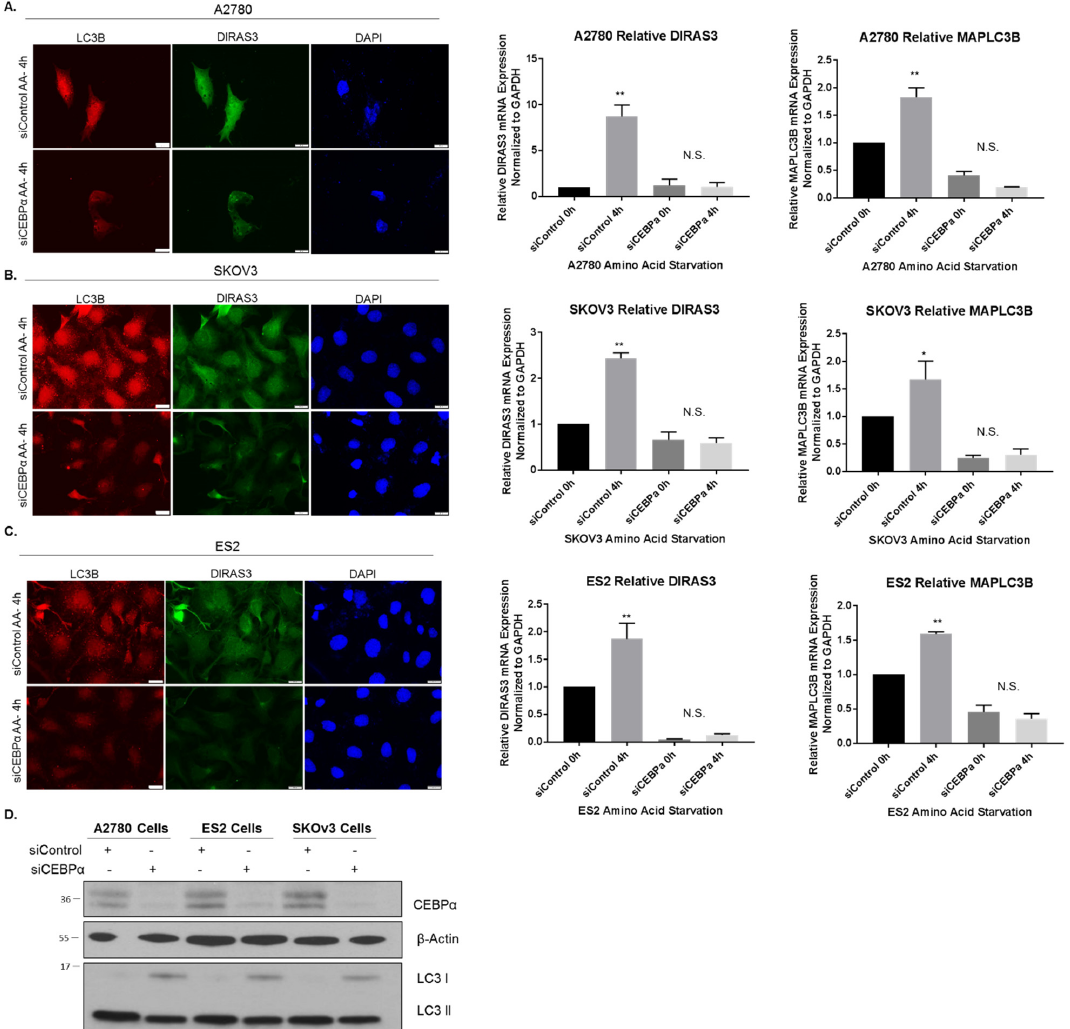
Figure 7. Knockdown of CEBP α reduces DIRAS3 upregulation following amino acid deprivation. A2780 ( A ) SKOv3 ( B ) and ES2 ( C ) ovarian cancer cells were treated with control siRNA or siRNA against CEBP α for 72 h prior to amino acid starvation for 4 h. Immunofluorescent staining was performed as indicated. qRT-PCR was performed and DIRAS3 and MAPLC3B mRNA expression was determined relative to GAPDH. The experiment was performed three independent times with technical duplicates. Bars indicated the mean ± the standard deviation; * p < 0.05 and ** p < 0.01. ( D ) Western blot analysis was performed to document the knockdown e ffi ciency of CEBP α following siRNA treatment. Raw data films for western blot analysis shown in Figure